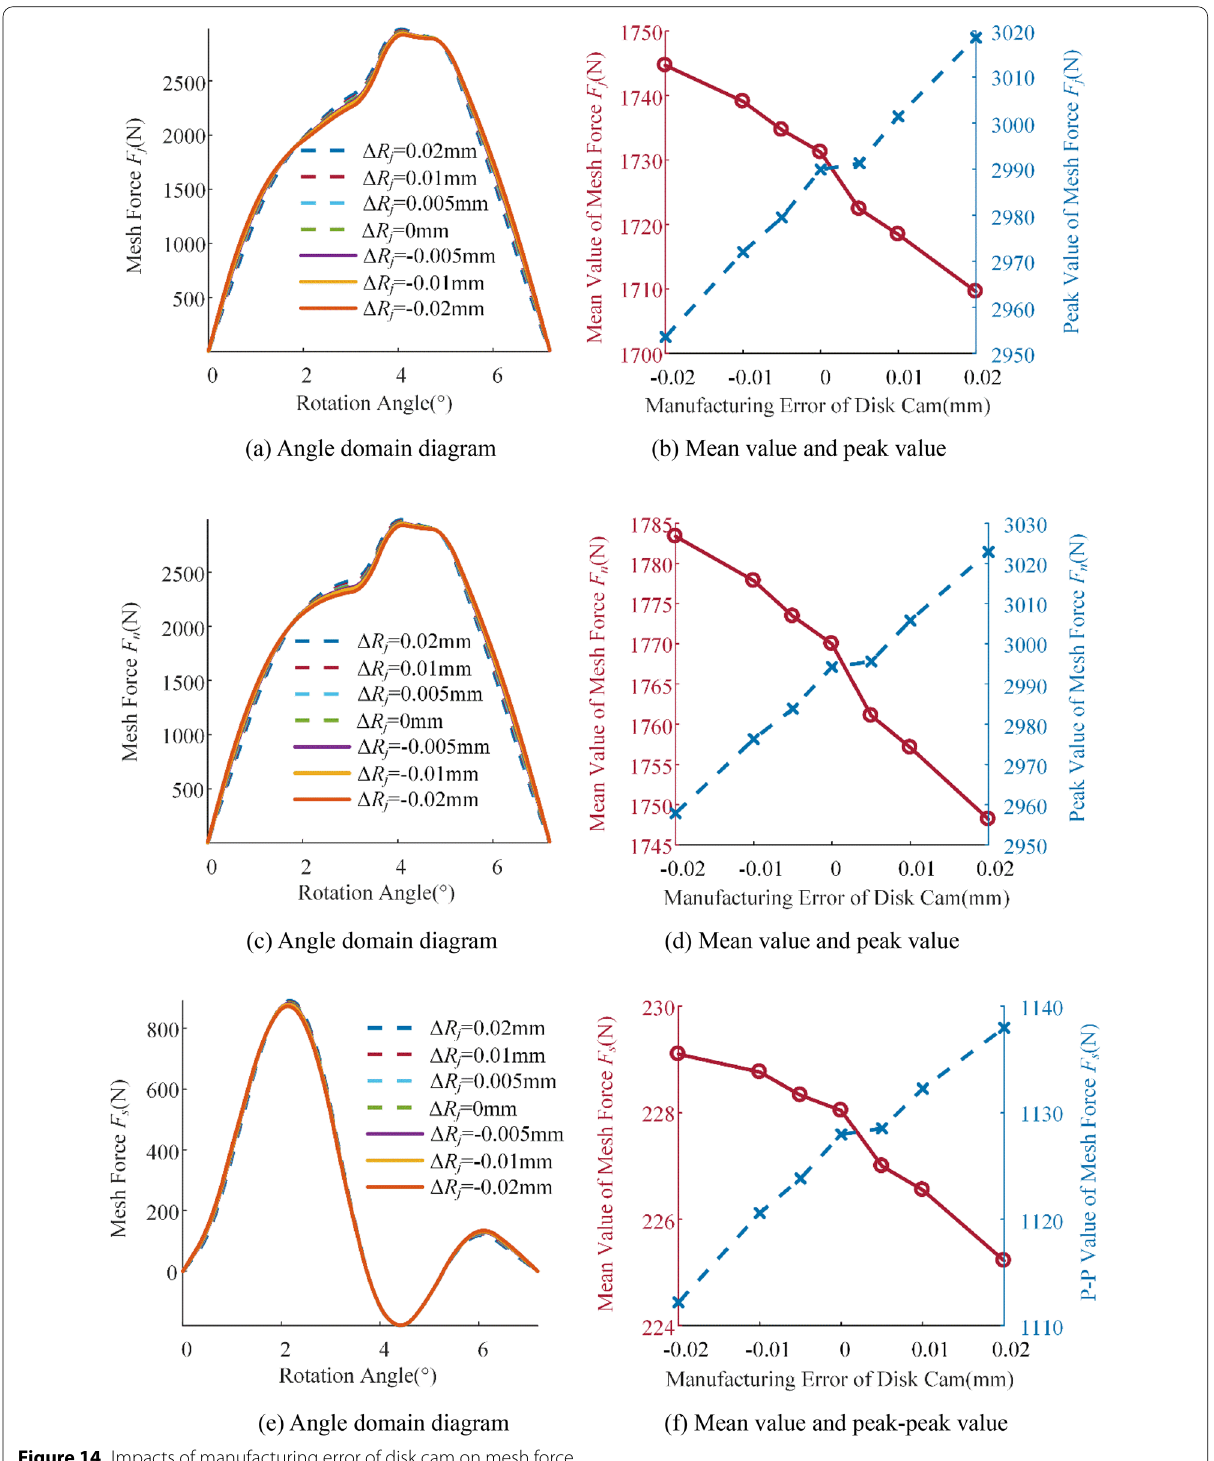
Figure 14 Impacts of manufacturing error of disk cam on mesh